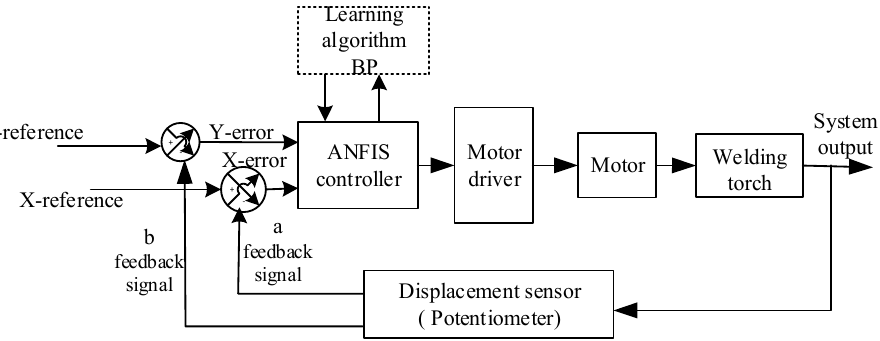
Figure 8. The proposed closed control system. BP—backpropagation.